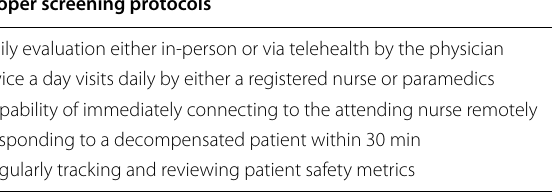
Table 1 CMS list of requirements for acute